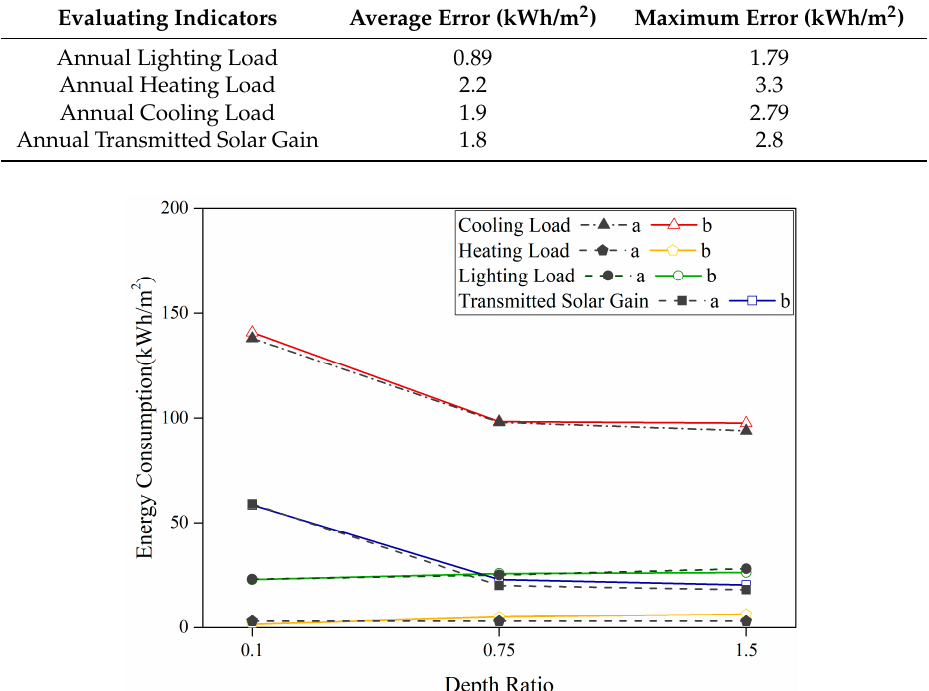
Table 3. Typical errors of verification.